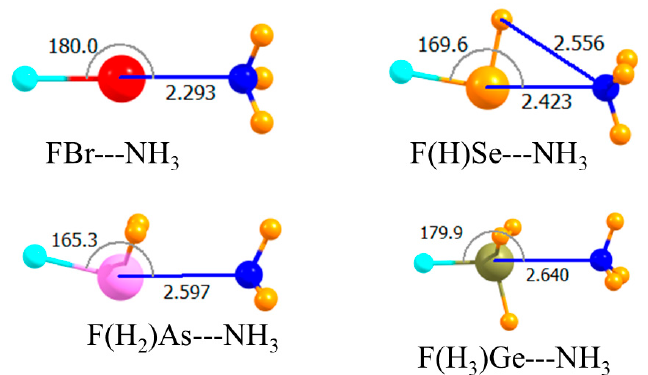
Figure 5. Optimized geometries of complexes involving a partially mono-fluorinated Lewis acid with one F atom opposite N. Intermolecular distances are in Å, angles in